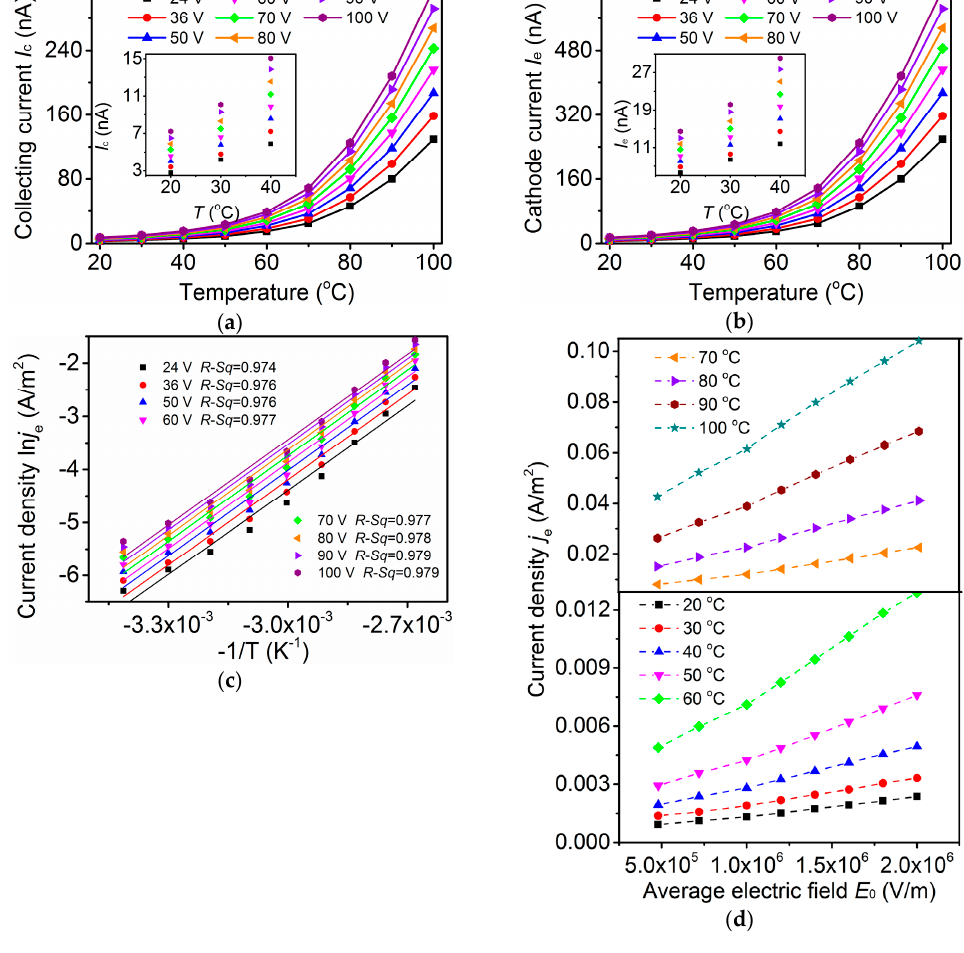
Figure 2. Effect of temperature on current at different U e . ( a ) Collecting current–temperature characteristic and ( b ) Cathode current–temperature characteristic at 24–100 V U e ; ( c ) ln j e increased